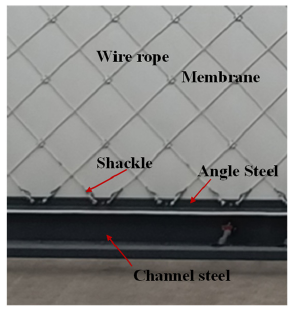
Figure 14. Cable network connection.